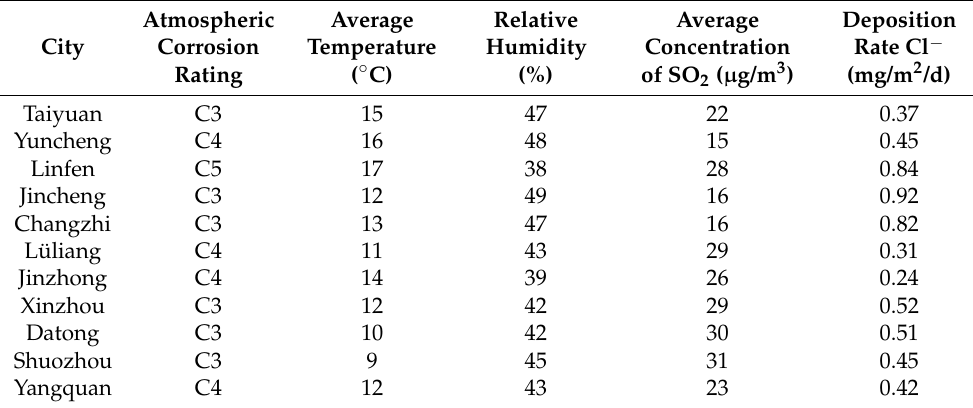
Table 5. Atmospheric corrosion monitoring data of 11 cities in Shanxi